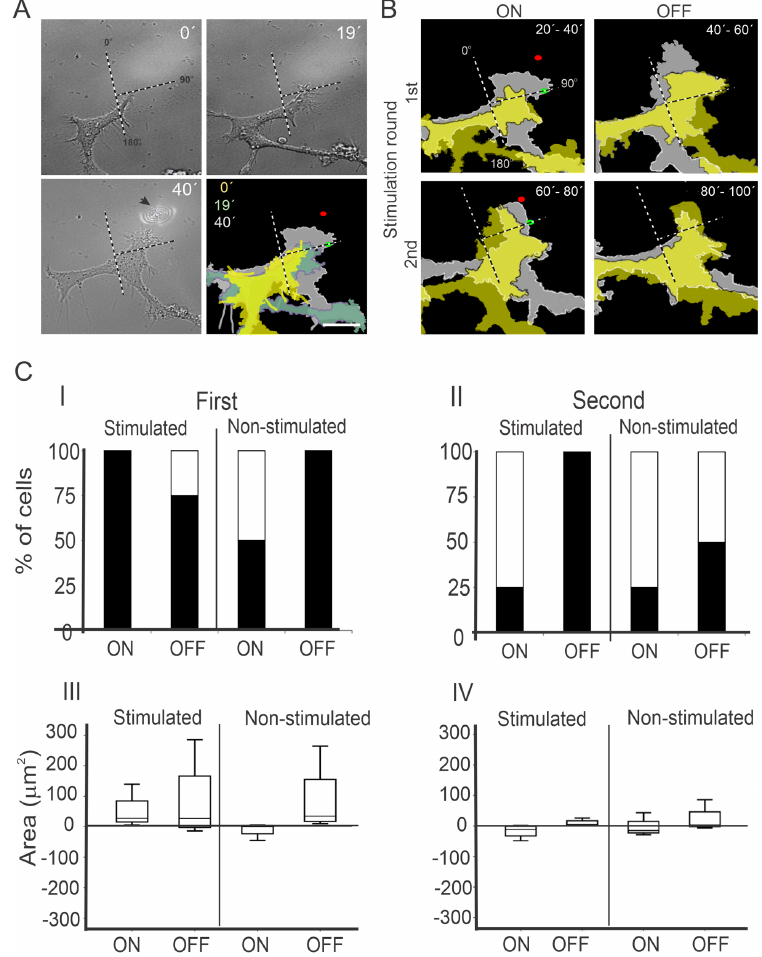
Figure 1. Optical guidance of PC12 cells during the ON and OFF period of laser stimulation. ( A ) Example of a time lapse of DIC microscopy images of PC12 cells obtained before NIR laser stimula- tion (T = 0 ′ , T = 19 ′ ) and after 20 min of NIR laser irradiation (T = 40 ′ ). The arrow in the 40’ frame indicates the laser spot. The superposition of colored areas shows the direction of projection of the growth cones. ( B ) Example of growth cone projection while the laser was ON and OFF, respectively. The superimposed colored areas indicate the growth cone contour at beginning (yellow) and the end (gray) of the temporal periods indicated at the right-top corner of each frame. Dotted lines in A and B show the division in two zones (0–90° and 90–180°), green and red dots mark the position of the laser spot at the beginning and the end of the stimulation, respectively. ( C ) Quantification of PC12 growth cone projection. Subpanels I and II show the percentage of cells with increased (black) or decreased (white) growth cone area at stimulated (0–90 ◦ ) and non-stimulated quadrants (90–180 ◦ ), and during the laser ON and OFF periods at the first (I) and second (II) round of laser stimulation. III and IV show box-and-whisker diagrams of the difference of the growth cone areas at the end and beginning of the 20 min periods (refer to Section 2.4), at stimulated and non-stimulated quadrants, during the ON and OFF periods, in the first (III) and second (IV) round of laser stimulation. The scale bars in ( A , B ) represent 15 µ